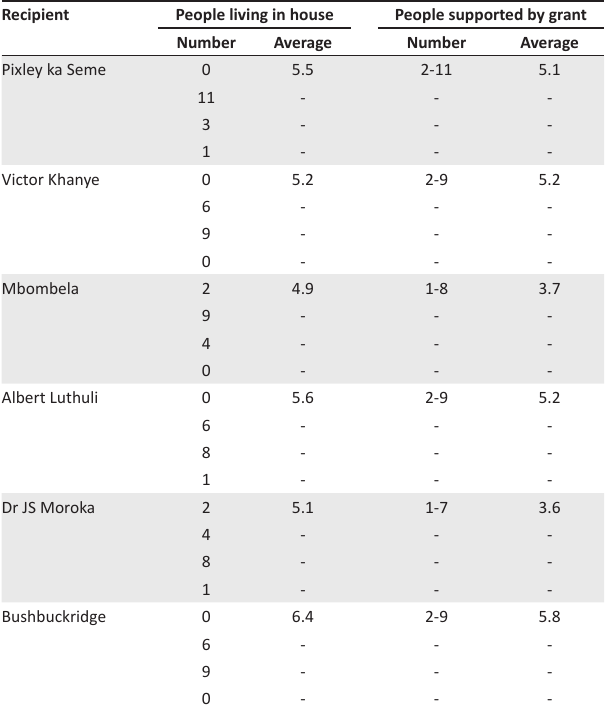
TABLE 2: Demographic profile of recipient of the disability grant and household members in the urban ( n = 45) and rural municipalities ( n = 45).